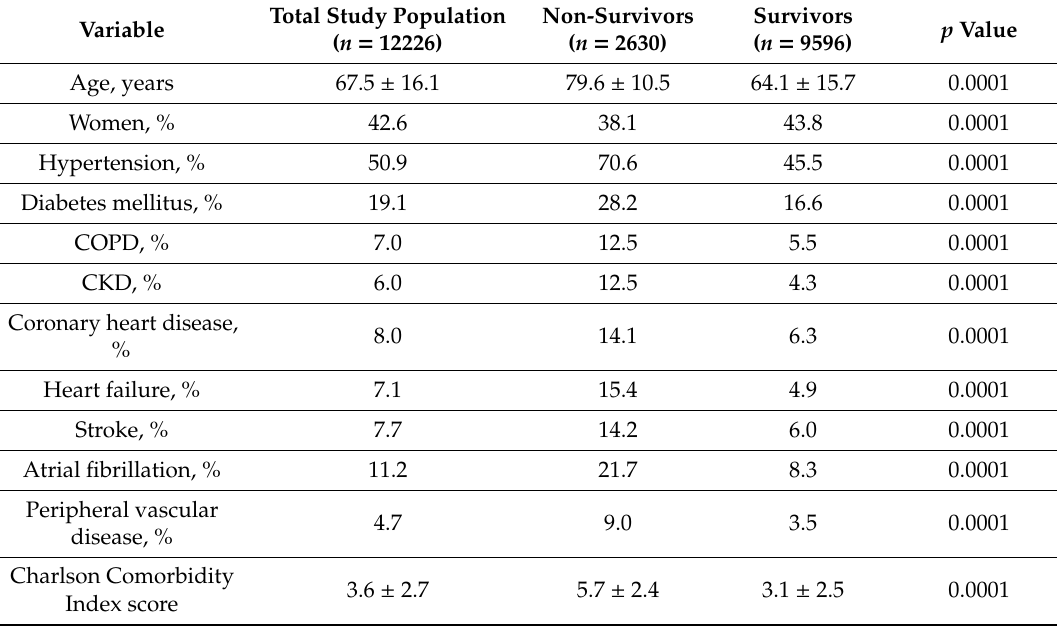
Figure 1. Patient inclusion flow chart. Table 1. Demographic and baseline clinical features of the study population. COPD: chronic obstructive pulmonary disease; CKD: chronic kidney